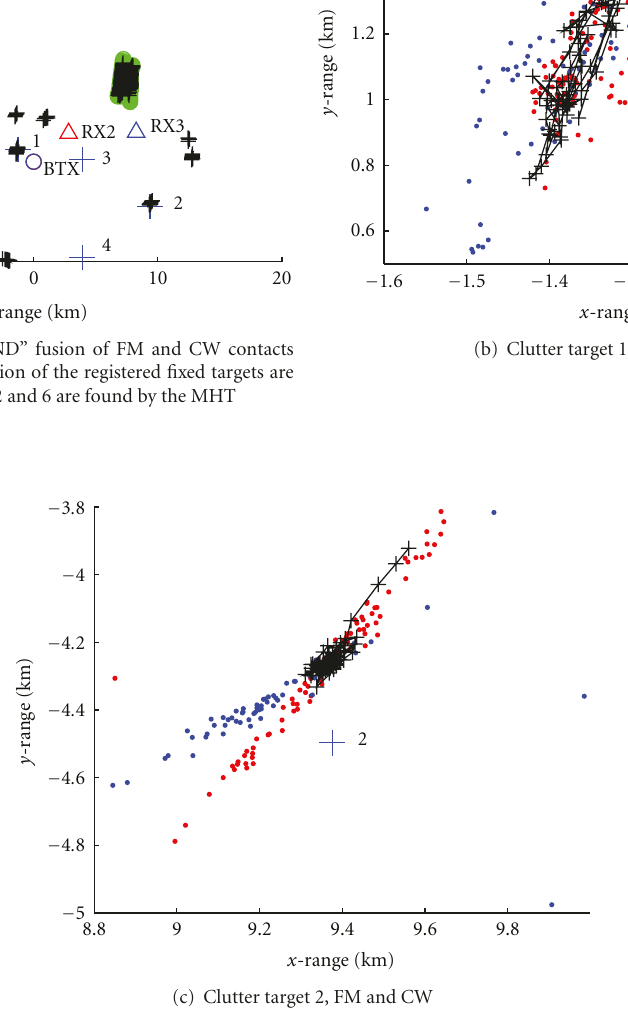
Figure 14: Tracking of bottom targets.